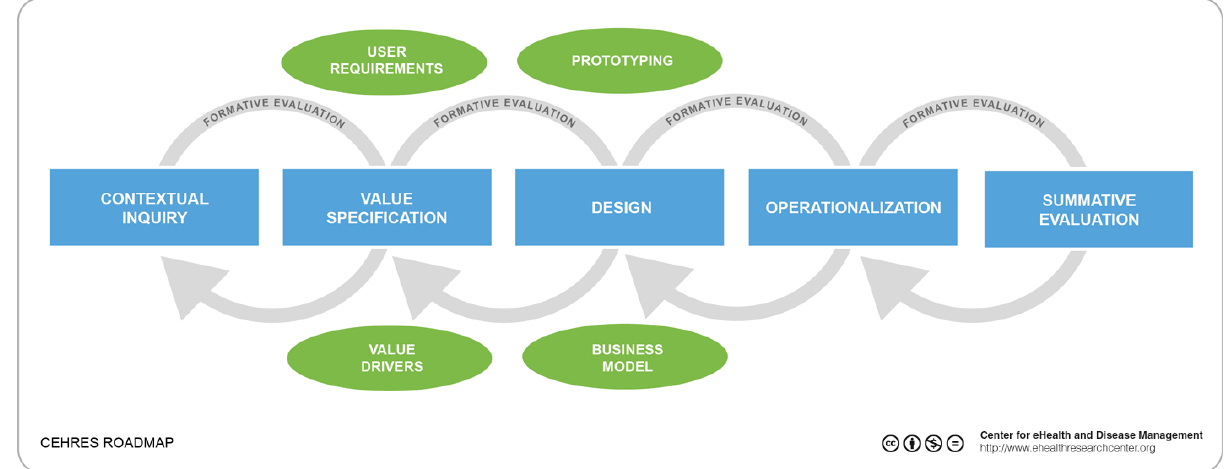
Figure 1. CeHRes